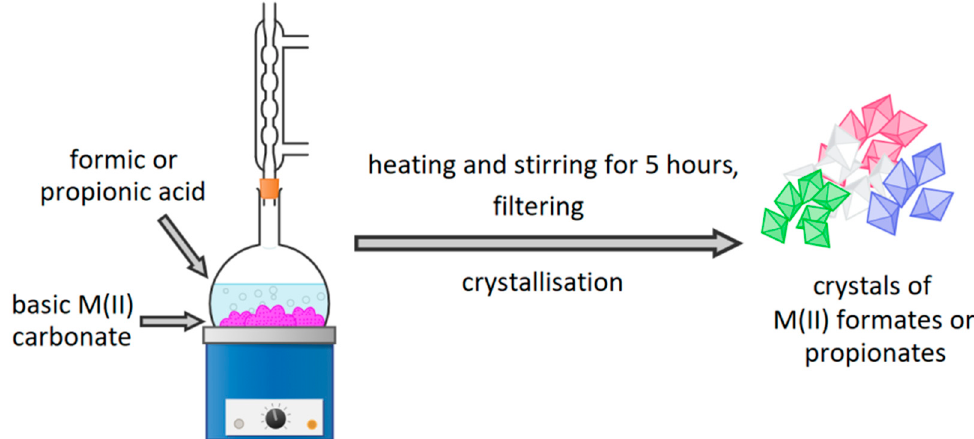
Figure 1. Synthesis of appropriate M(II) formates and propionates.